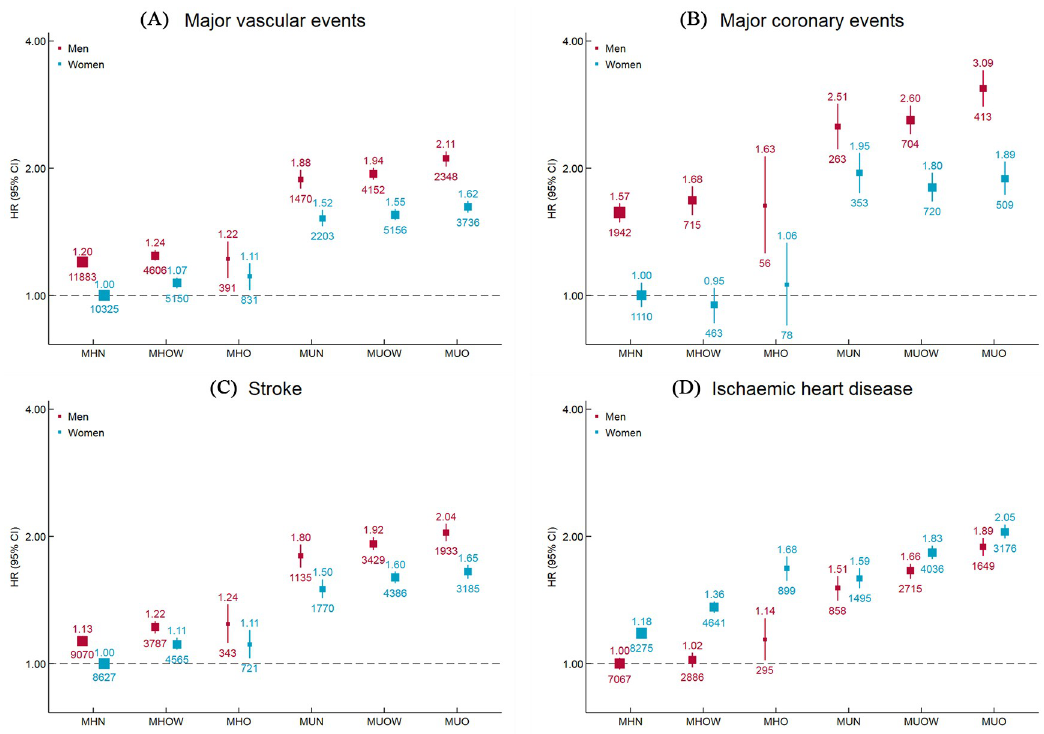
Fig 3. Adjusted HRs for cardiovascular diseases subtypes by BMI-metabolic health status and sex. Values shown are the HR (95% CI) for (A) major vascular events, (B) major coronary events, (C) stroke, and (D) ischemic heart disease, by BMI-metabolic health status and sex. HRs are adjusted for age, study region, education, household income, marital status, smoking, alcohol use, red meat intake, fresh fruits intake, fresh vegetables intake, physical activity, and family history of heart attack or stroke. The vertical lines indicate 95% CIs. The values above the squares indicate HRs and the values under the squares indicate number of cases in each category. The size of the squares is proportional to the inverse variance of each effect size. BMI, body mass index; CI, confidence interval; HR, hazard ratio; MHN, metabolically healthy normal weight; MHO, metabolically healthy obesity; MHOW, metabolically healthy overweight; MUN, metabolically unhealthy normal weight; MUO, metabolically unhealthy obesity; MUOW, metabolically unhealthy overweight.